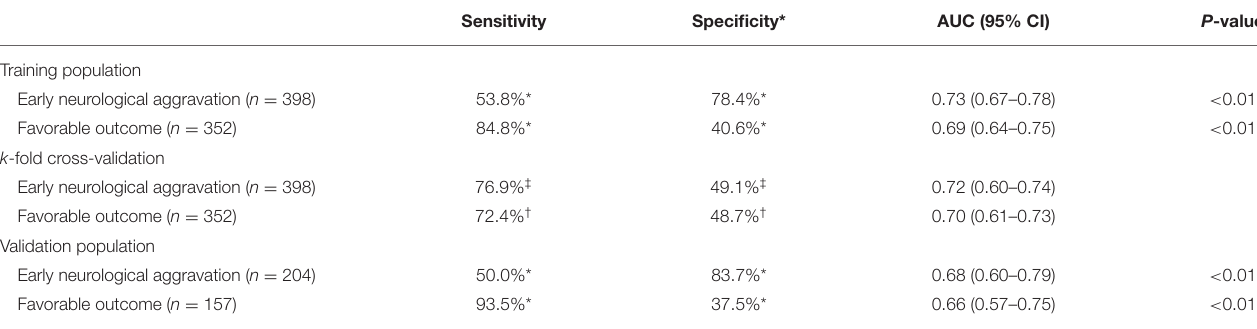
TABLE 5 | Internal and external validation of the TAB-TICI score performance.